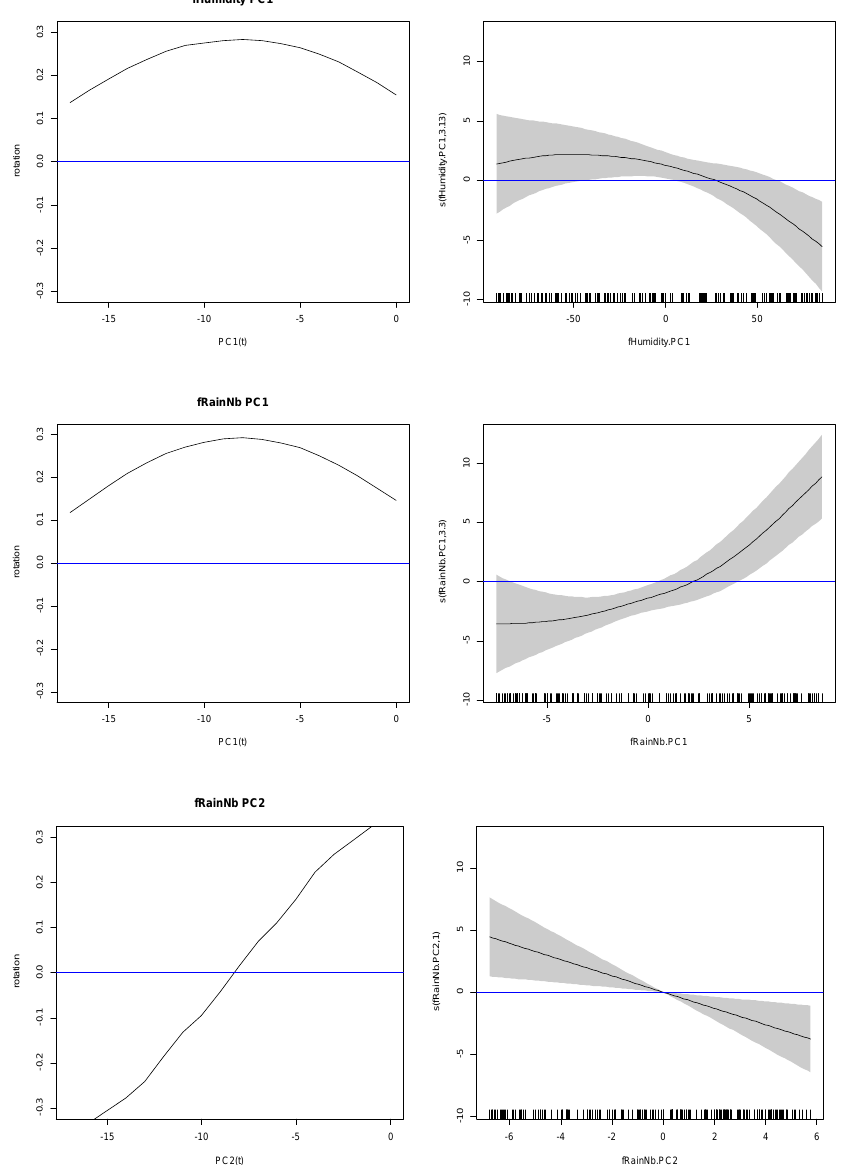
Figure 4. Some chosen principal component (PC) and their associated smooth functions g . g The shape of fHumidity.PC1 over the mean leads to fewer cases of malaria, and the curve of fHumidity below the mean leads to an increased malaria incidence. The shape of fRainNb.PC1 over the mean leads to an increase in malaria incidence, whereas the number of rain events below the mean slightly decreases the malaria incidence. The relationship among fRainNb.PC2 and the response is linear. The effect covariates fWindspeed and fIncidence on malaria incidence are weak.